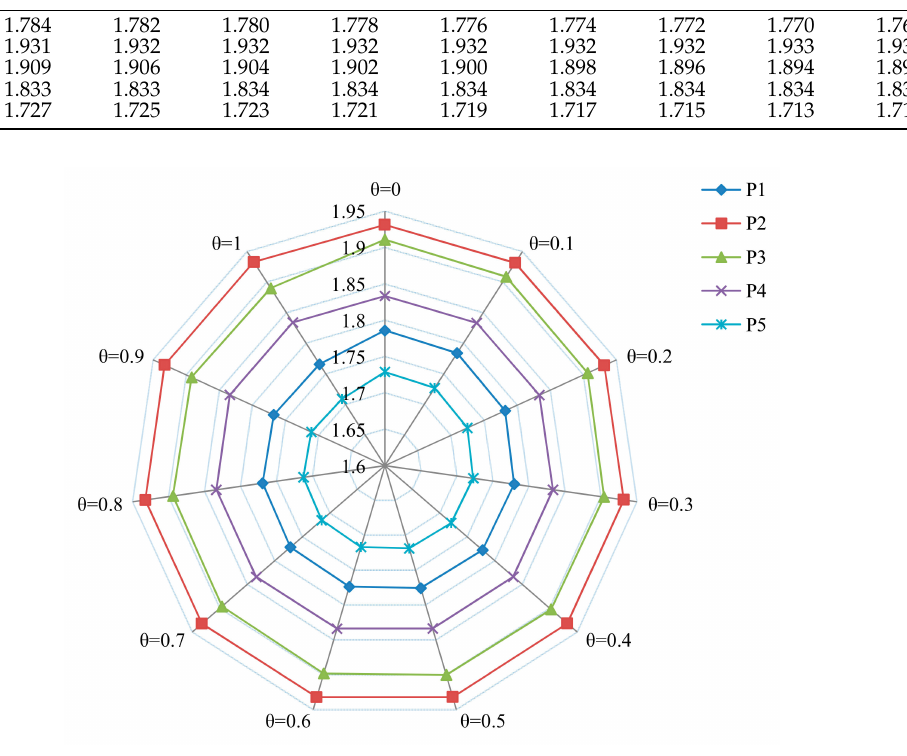
Figure 3. Sensitivity analysis of alternatives for parameter θ .